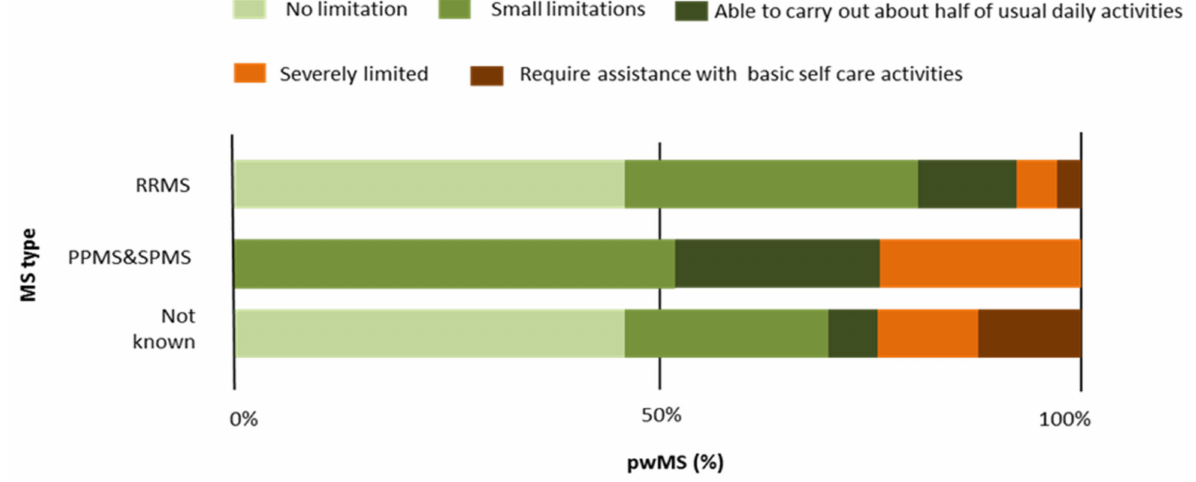
Figure 1. Average percentages of overall wellness (functional abilities) with regard to MS type.